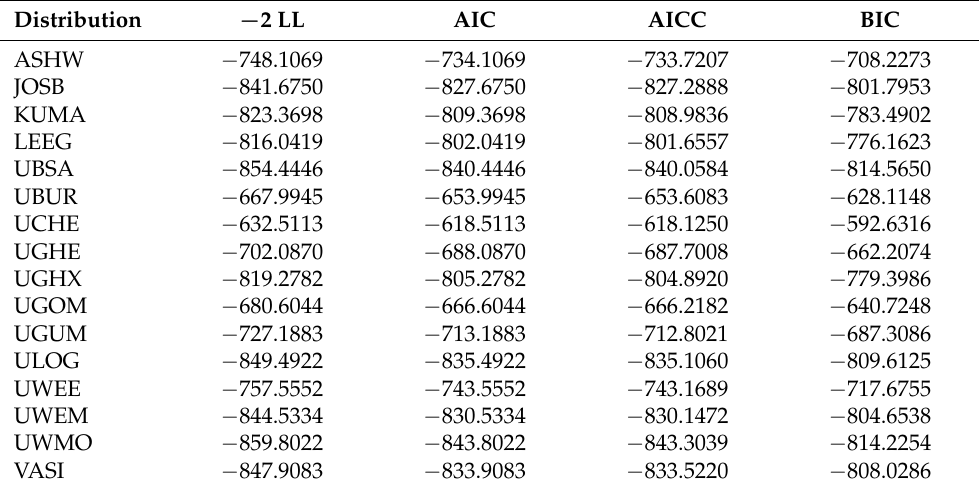
Table 12. Values of the indicated likelihood-based statistic and distribution for τ = 0.25 with data related to fat percentage at the legs.